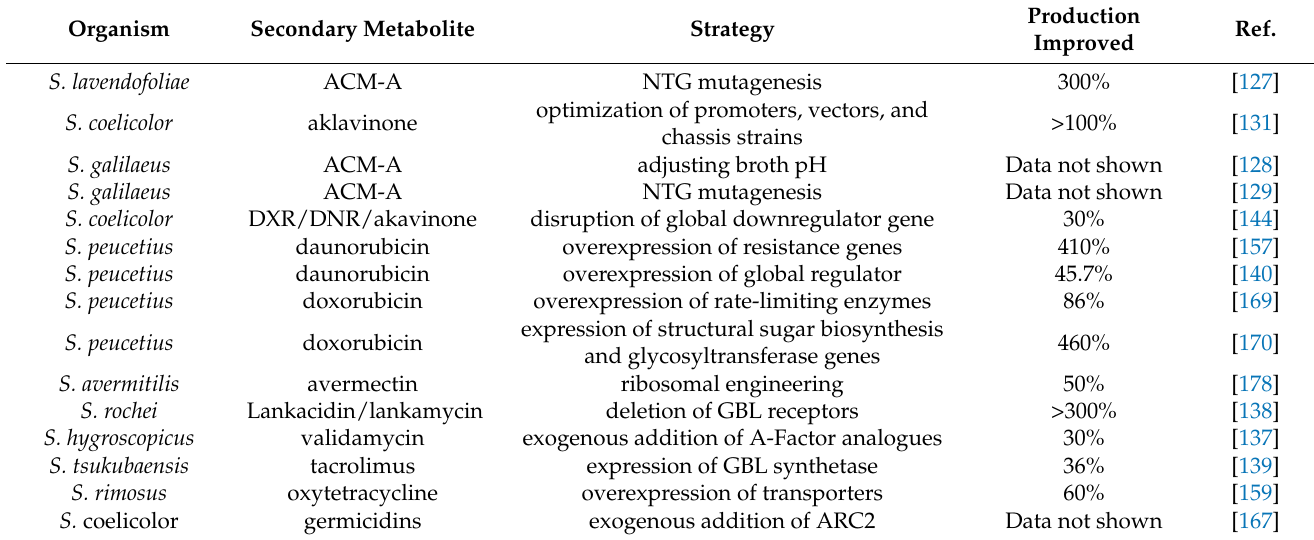
Table 3. Strategies for improving the desired metabolites in Streptomyces